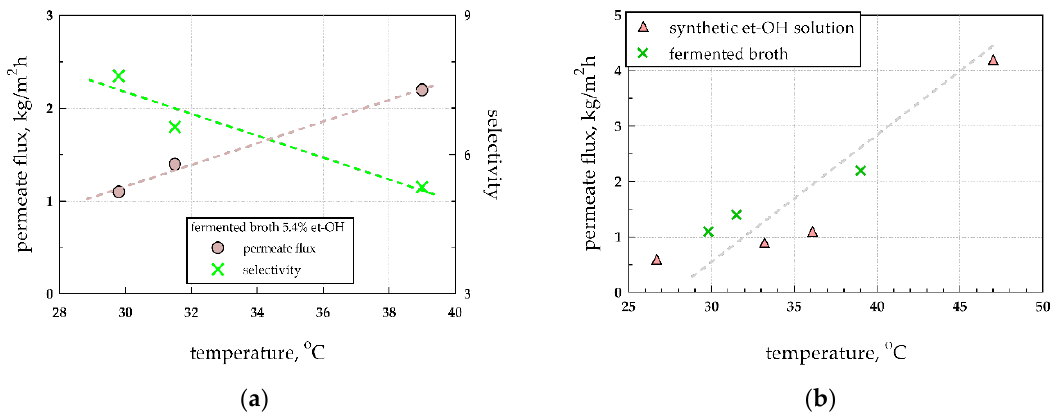
Figure 7. ( a ) Permeate flux and selectivity versus the feed solution temperature for fermented broth solutions; average ethanol concentration 5.4% v / v ; and ( b ) comparison of synthetic ethanol solutions and fermented broth solutions.